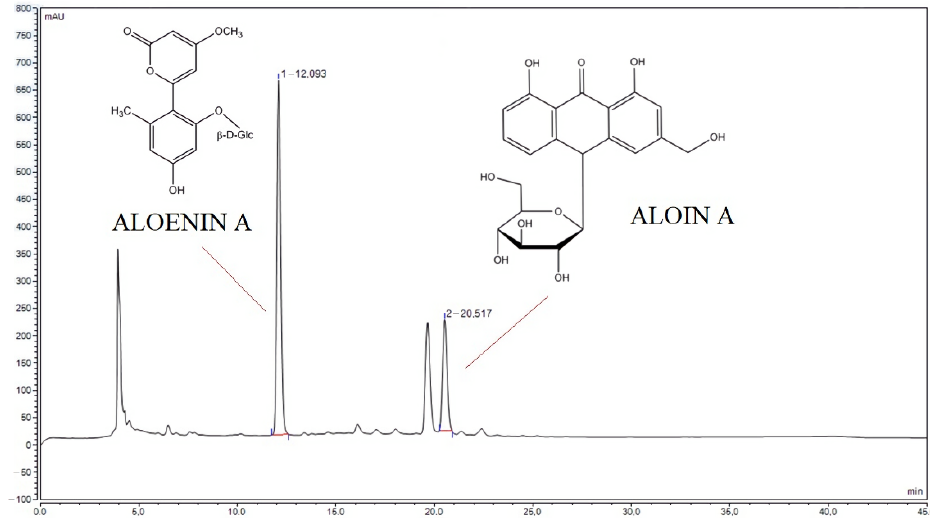
Figure 1. The HPLC chromatogram of lyophilized aloe gel with selected patterns of aloenin A and aloin A.